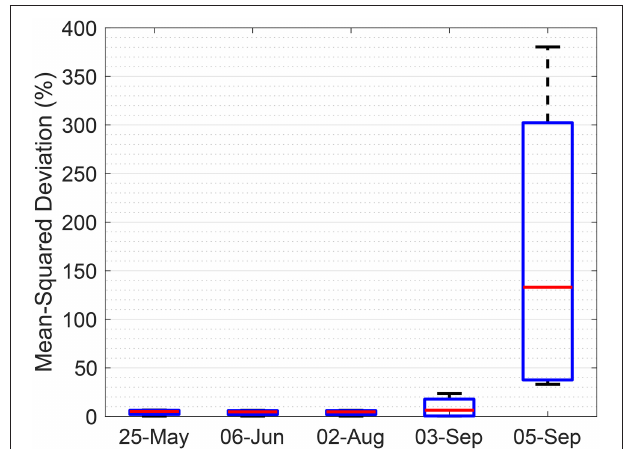
FIGURE 9 | Variation of data collected from four sensors during 2017, as compared against vehicle traffic trends. A large deviation around September 4th (Labor Day Walk) is